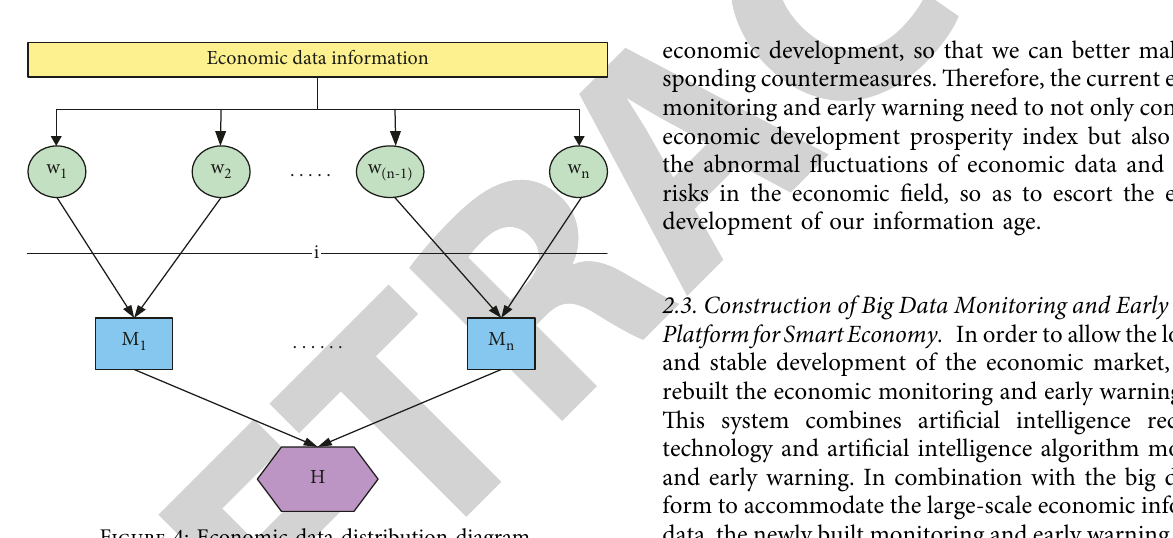
Figure 3: Flow chart of intelligently identifying economic risks.